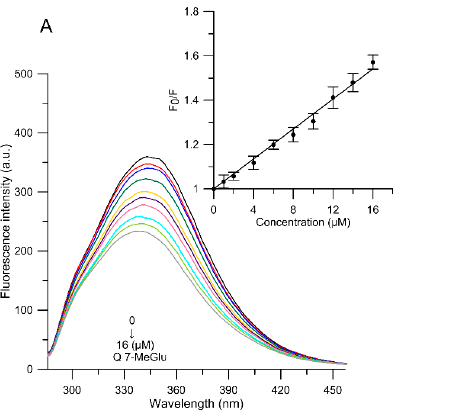
Figure 3. Emission spectra of HSA in the presence of various concentrations of ( A ) quercetin 7- O - β - D -(4 ″ - O -methyl)glucopyranoside (Q 7-MeGlu); ( B ) quercetin (Q), and Stern-Volmer plots of F 0 /